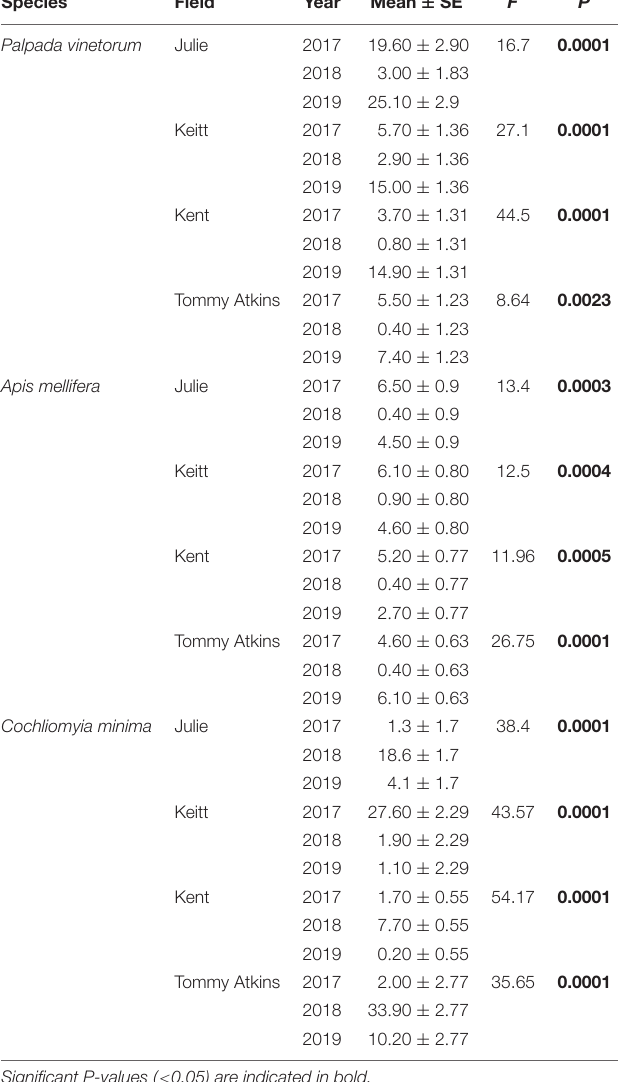
TABLE 2 | Repeated measures ANOVA analyses testing for annual differences in the average abundance (number of insects observed/tree/day) of dominant insect species for each four fields of M. indica each containing a different cultivar.